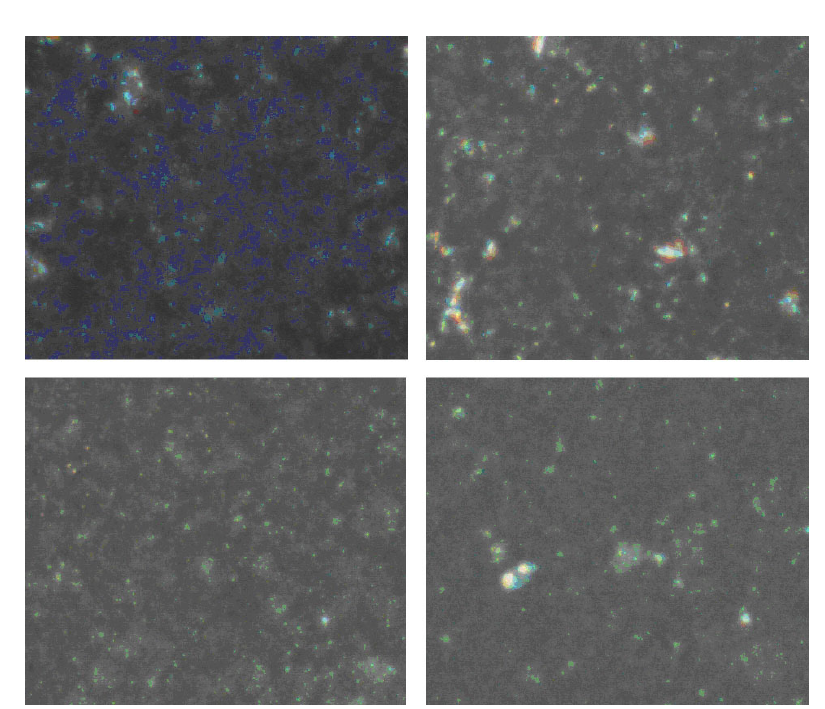
O (top, left) and ceramics obtained by annealing precursor gels with nominal 2 4